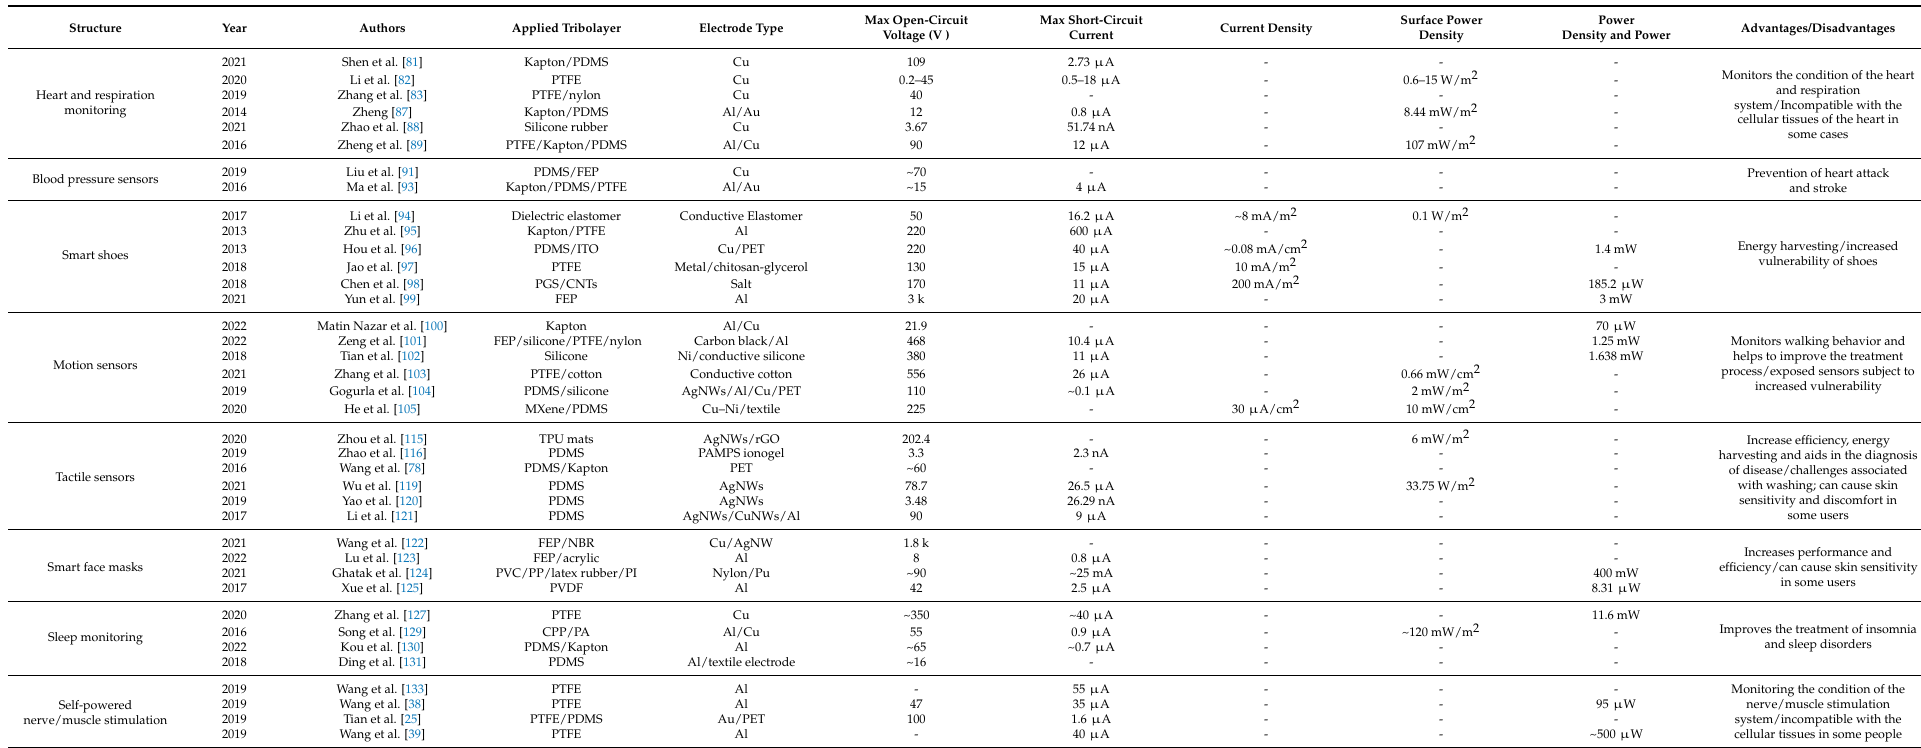
Table 1. Summary of various TENG techniques for biomedical